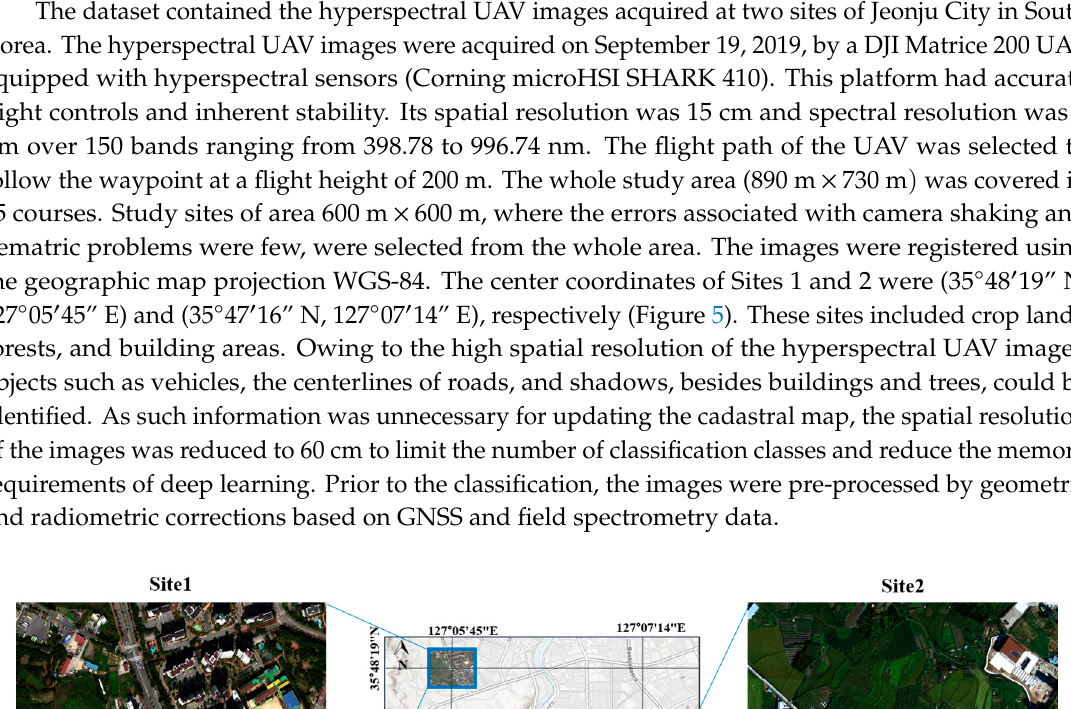
Figure 6. Cadastral map of the study sites in South Korea: ( a ) Site 1, ( b ) Site 2. 4. Results 4.1. Classification Results The hyperspectral UAV images were classified by the proposed hybrid CNN. The network was optimized in 30 epochs of Adam with a learning rate of 10 (cid:2879)(cid:2871) and a batch size of 256. The Adam optimizer is a combination of the stochastic gradient descent with momentum and RMSprop, and has relatively low memory requirements and is quite computationally efficient [33]. At the start of each iteration, the network was randomly initialized. The ground-truth data were manually defined from the field data. The field work acquired the spectral libraries and types of surface materials. The ground truth was composed of 88,567 pixels and contained six classes: crops, forests, roads, buildings,